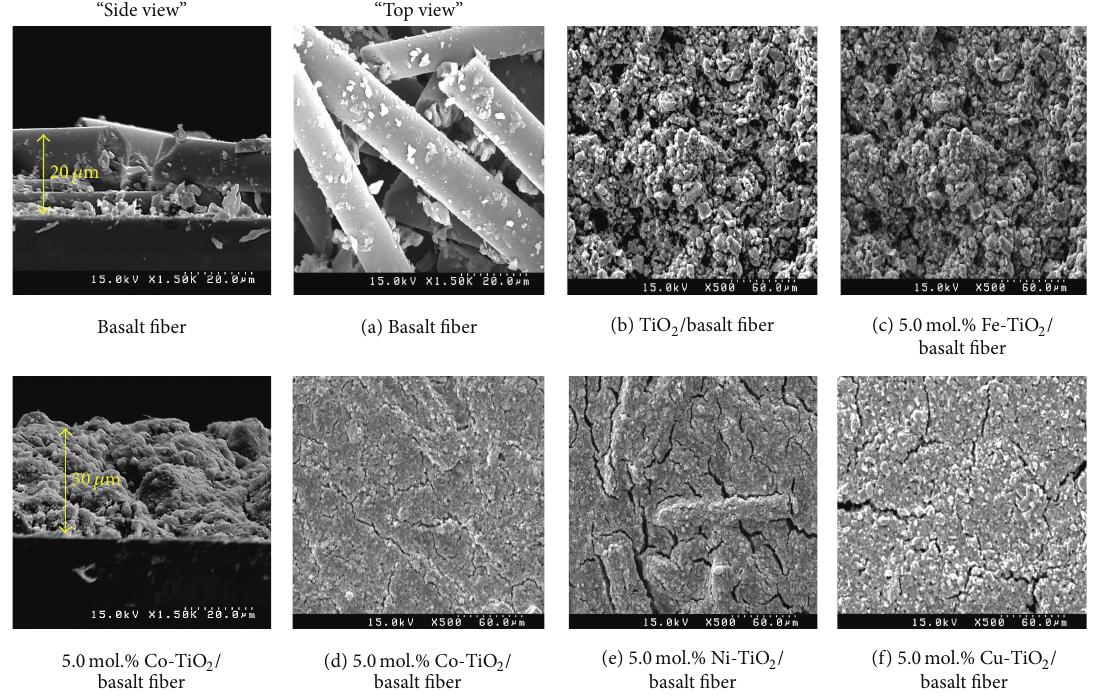
Figure 7: SEM images of the pure basalt fiber film and 5.0 mol.% M-TiO 2 /basalt fiber